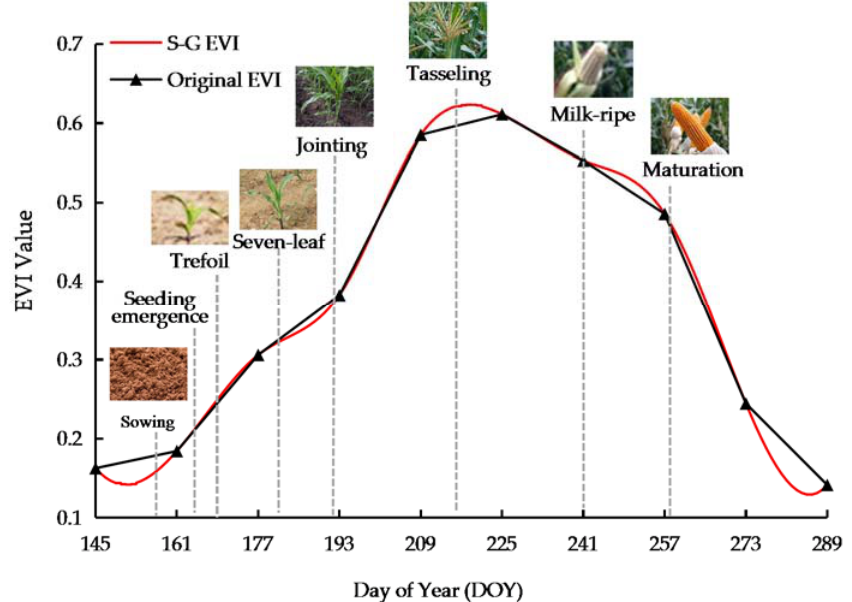
Figure 6. Moderate Resolution Imaging Spectroradiometer (MODIS) EVI time series curve of summer maize in the reference area.